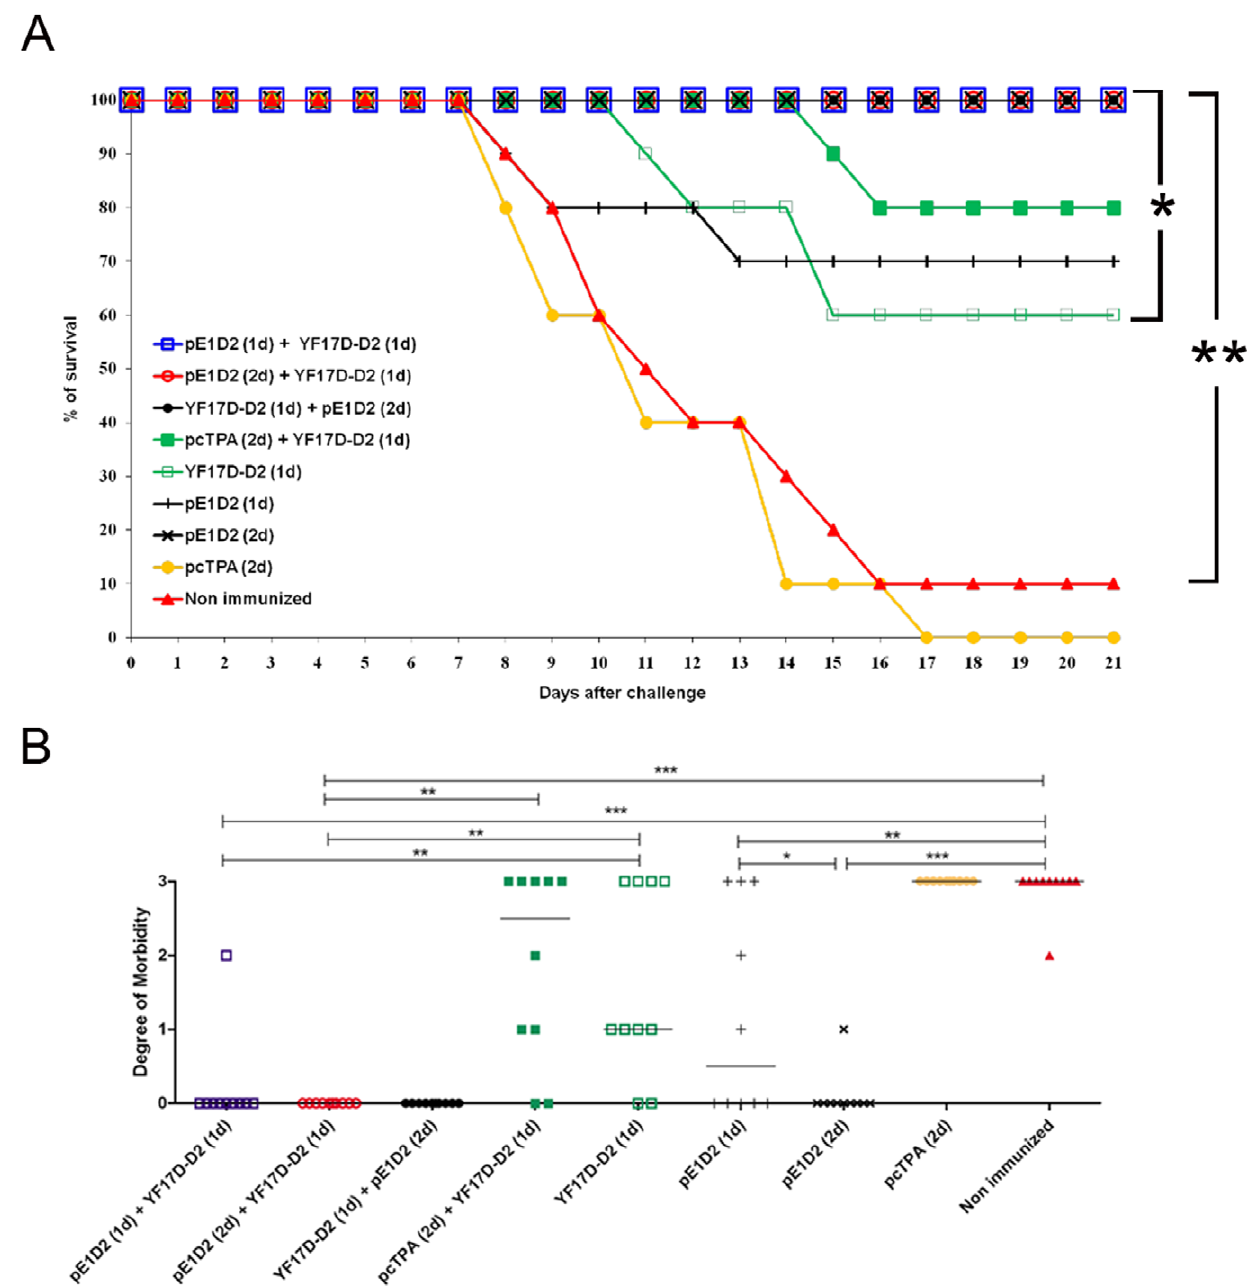
Figure 3. The protective efficacy of vaccination with pE1D2 and YF17D-D2 against DENV2 in prime-booster regimen. Groups of Balb/ c mice (n=10) were immunized with pE1D2 (i.m.) and/or YF17D-D2 (s.c.), administered singly or in a prime-booster regimen, and challenged (i.c.) with the NGC DENV2. Vaccinated and control mice were monitored for 21 days after challenge with the record of survival rates (A) and degree of morbidity (B). Asterisks indicate statistically significant differences using the chi-square test in (A) (*p , 0.001; **p , 0.0001) and the Mann-Whitney test in (B) (*p , 0.05; **p , 0.01, ***p , 0.001). One dose=1d; two doses=2d.